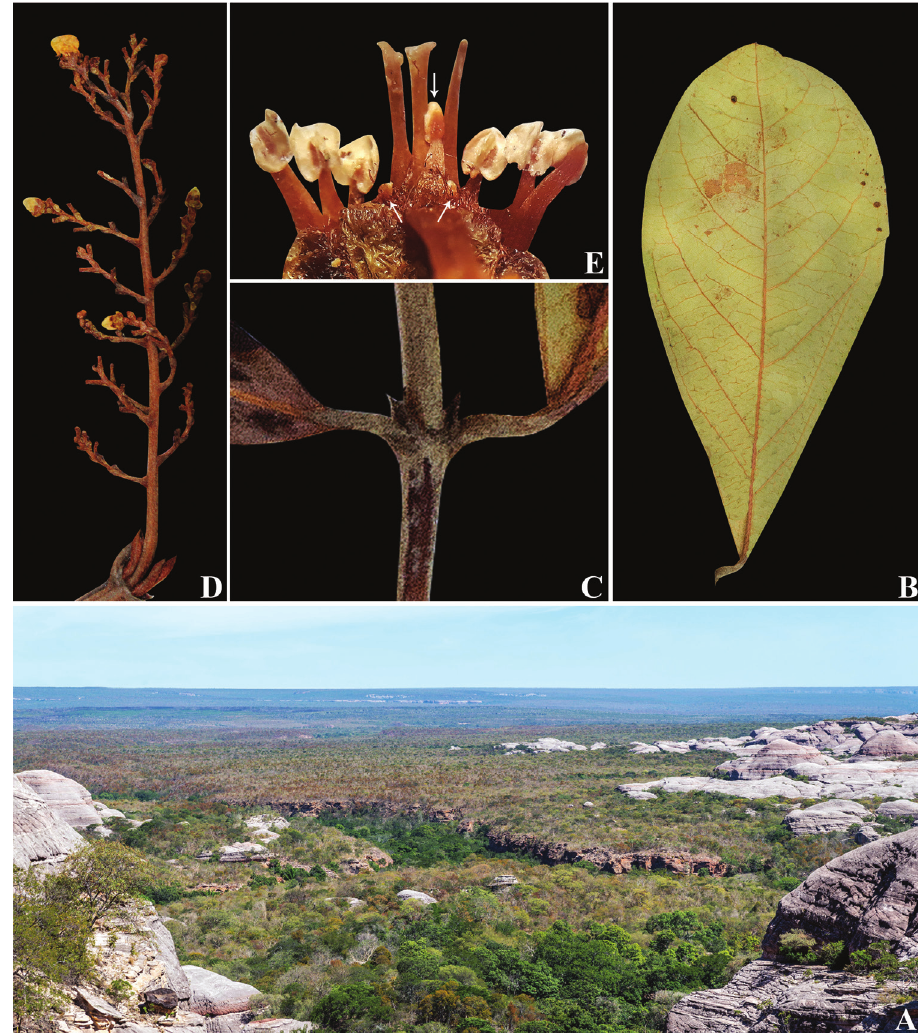
Figure 7. Mcvaughia piauhiensis . A seasonally dry forests from Serra das Confusões, Piauí, Brazil B abaxial surface of a leaf C detail of epipetiolar stipules D inflorescence E rehydrated flower showing the stamens (white arrows= reduced stamens) and styles. A by S.E. Martins B–E by R.F. Almeida. green in sicco , initially lanate-velutinous to glabrescent, except from midvein at base, a pair of conspicuous glands at base abaxially, on each side of the midrib, a few inconspicuous glands scattered on the blade, with 2 conspicuous glands near apex; petiole 0.8–1 cm long, canaliculate, densely lanate-velutinous, eglandular. Thyrsi of 5–8-flowered cincinni; rachis 6.5–7 cm long, smooth, densely tomentose-velutinous, with rusty hairs; lateral cincinni 14–15, alternate; bracts 1.5–2.5 mm long, triangular, appressed to the peduncle, eglandular, tomentose-velutinous; peduncle 3–4 mm